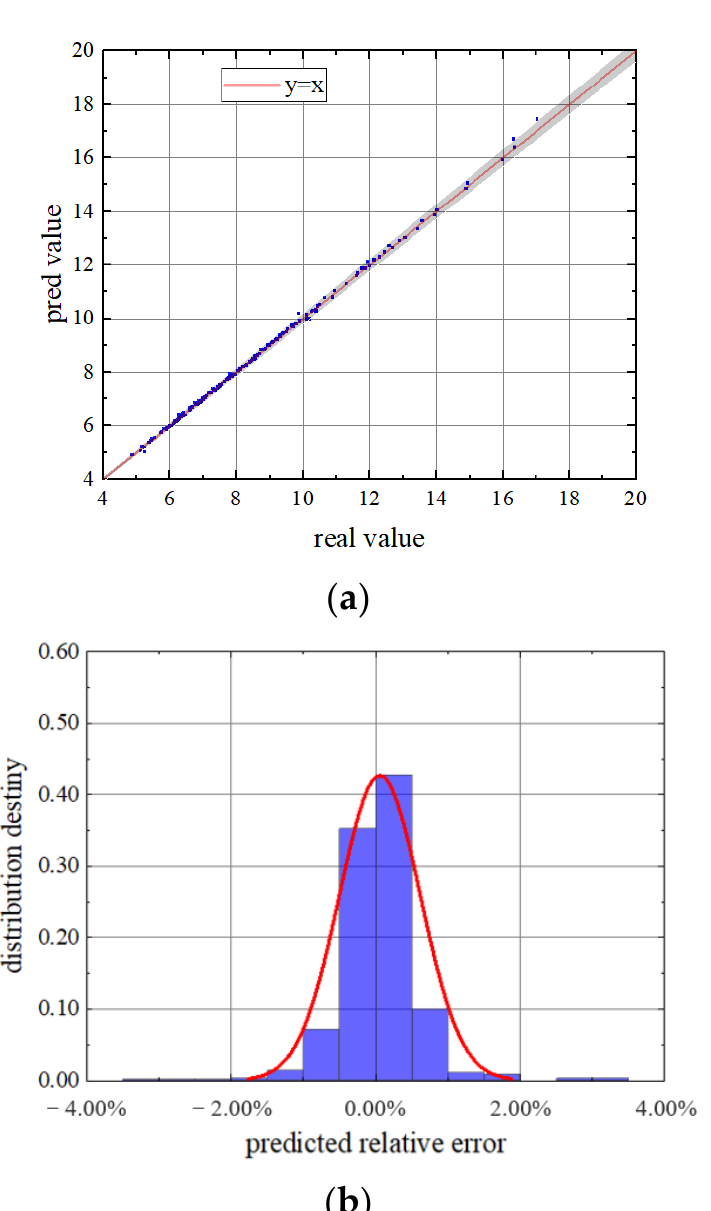
Figure 15. First order amplitude of axial flow force (( a ) Predicted value and true value; ( b ) relative error density